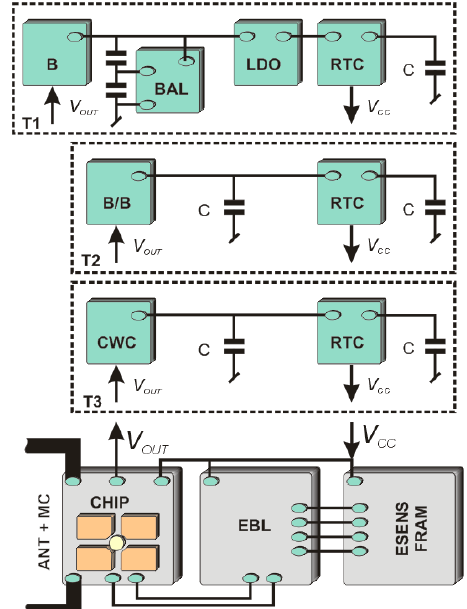
Figure 7. Considered model of data acquisition systems for quasi-autonomous RFID sensor. T1, T2, T3—versions of the energy conditioning and storage system; CWC—voltage regulator; B / B—Boost /